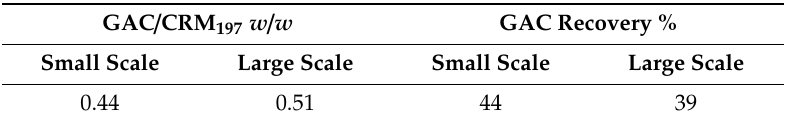
Table 4. Conjugates produced at di ff erent scale in optimized conditions confirming expected results in terms of GAC to CRM 197 ratio and process